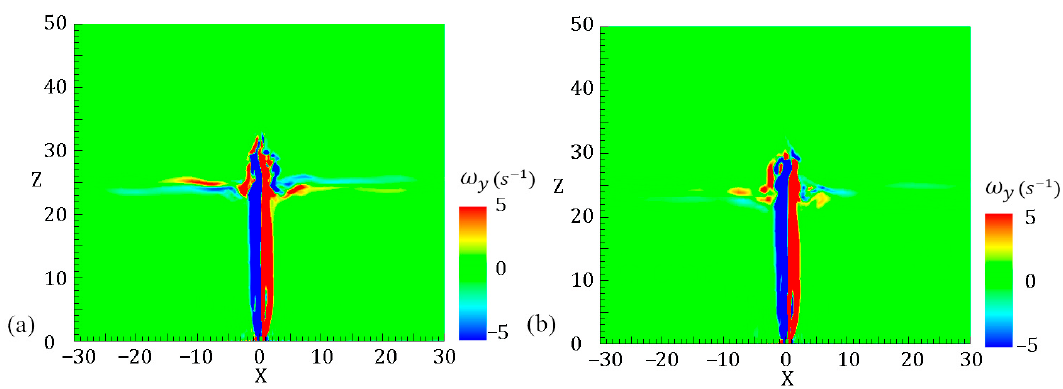
ω = 1.1 ( a ) and T = 2.2 ( b ) of case y at T